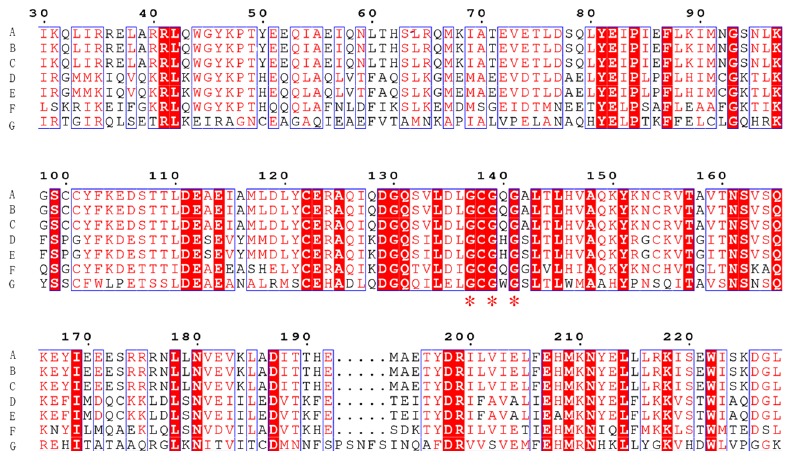
Figure 6. Conserved sequences identified by multiple gene sequence alignments. Alignment of Tetrahydroisoquinoline N-methyltransferase (from the Coptis japonica and from Methylotenera ) with its similar multiple sequences. Sequences highlighted in red indicate conserved regions. The abbreviations are as follows: A: (RS)-1-benzyl-1,2,3,4-tetrahydroisoquinoline N-methyltransferase, ag:BAB71802 K13384; B: Crystal structure of Coclaurine N-Methyltransferase, PDB: 6gkv; C: Crystal